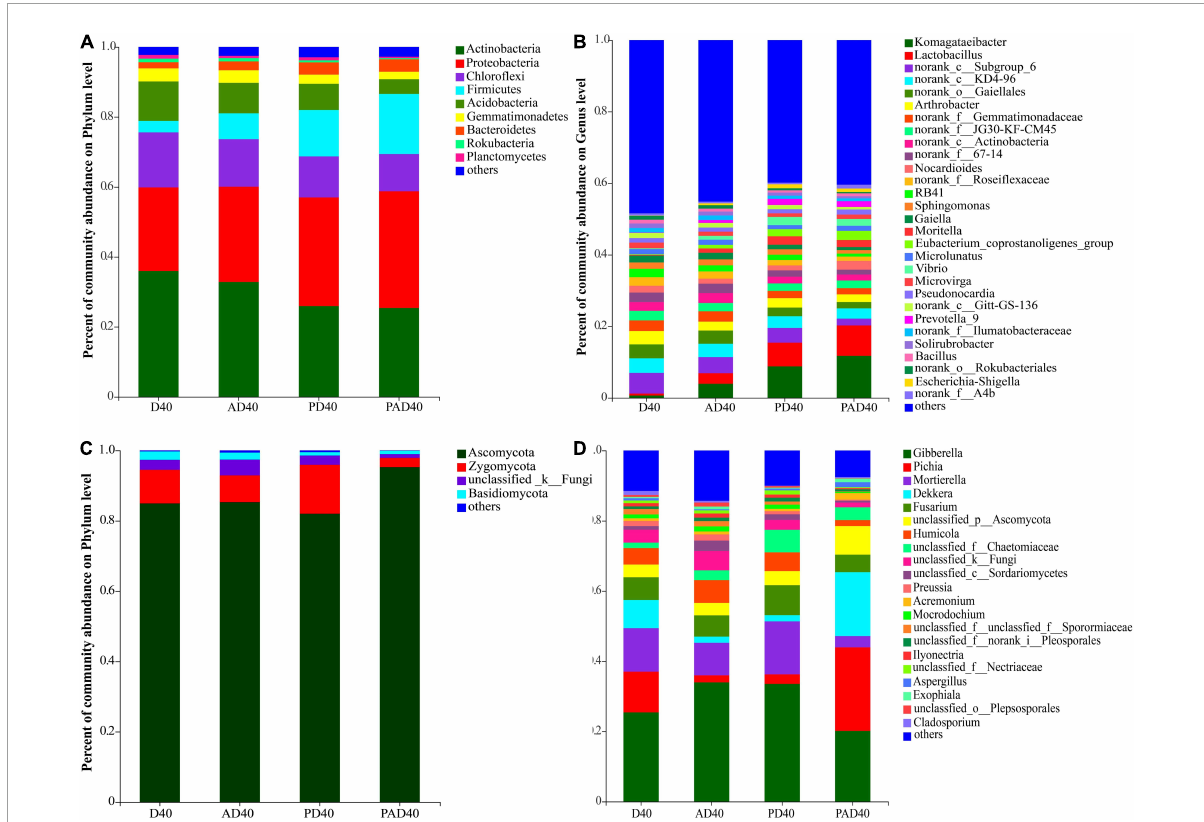
FIGURE4 Relative abundance of the rhizosphere microbial communities of ABA treated samples at phylum and genus level. (A) Bacteria phylum level; (B) bacteria genus level; (C) fungi phylum level; (D) fungi genus level. D40: severe desertified soil grew grass with 40 days drought; PD40: severe desertified soil grew grass with 40 days drought; AD40: severe desertified soil grew grass with 40 days drought and ABA treatment; PAD40: severe desertified soil grew grass, with 40 days drought, PAM, and ABA treatment.